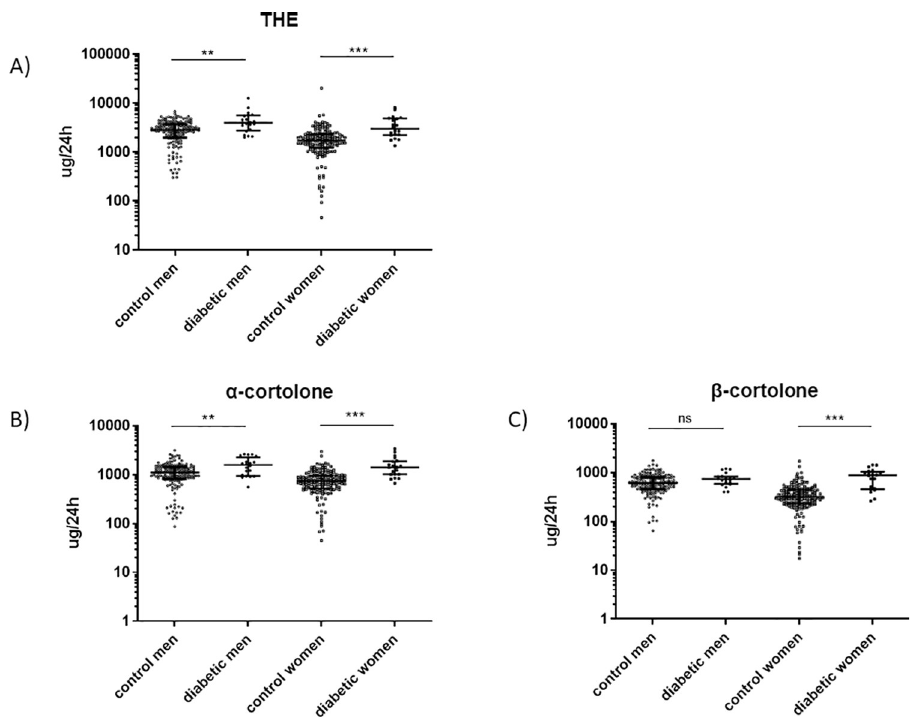
Fig 4. Urinary excretion of tetrahydrocortisone (THE), α -cortolone and β -cortolone in diabetic patients and healthy controls. Urinary excretion of the cortisone metabolites THE, α -cortolone and β -cortolone in non-diabetic (n = 155 for men, n = 161 for women) and diabetic patients (n = 21 for men and n = 20 for women) measured by GC-MS. The groups were matched for age and gender. Diabetic women excreted significantly more THE, α -cortolone and β -cortolone as their healthy controls. Men excreted significantly more THE and α -cortolone as healthy controls. There was no significant change in β -cortolone excretion between diabetic and healthy men. A) THE �� p = 0.004 (men), ��� p < 0.0001 (women). B) α -cortolone �� p = 0.009 (men), ��� p < 0.0001 (women). C) β -cortolone ns (men), ��� p < 0.0001 (women). Kolmogorov-Smirnov test (non-parametric, unpaired). Dot blot is shown with Log (10) scale and steroid concentrations are displayed in ug/24h. White circles = control men, black circles = diabetic men, white squares = control women, black squares = diabetic women. � p < 0.05, �� p < 0.01, ��� p < 0.0001, ns = not